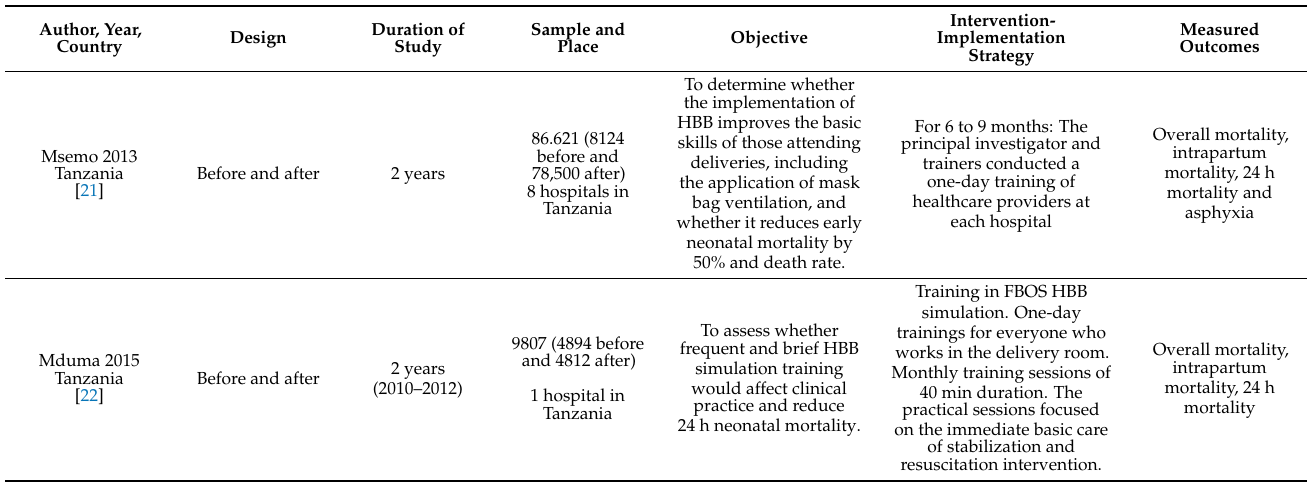
Figure 1. Study flowchart. Table 1. Characteristics of the included